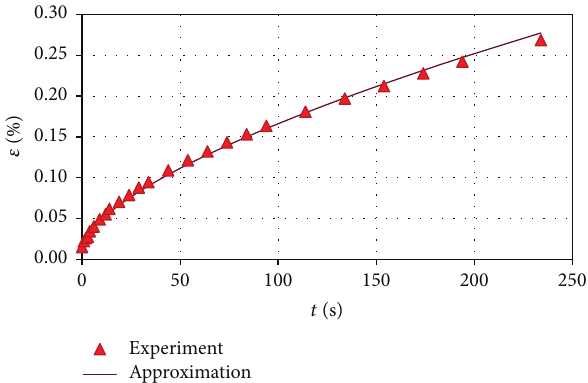
Figure 3: Creep curve of asphalt concrete at stress 𝜎 0 = 0 , 16 MPa.